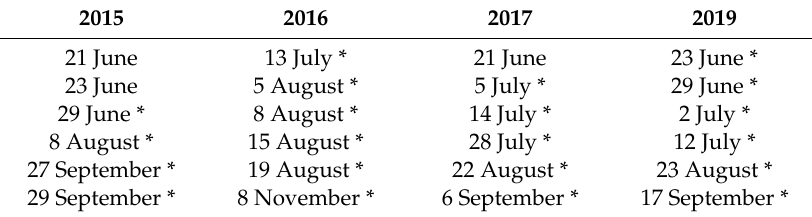
Table 1. Selected episode days during the study period that reported unusual pollen data in